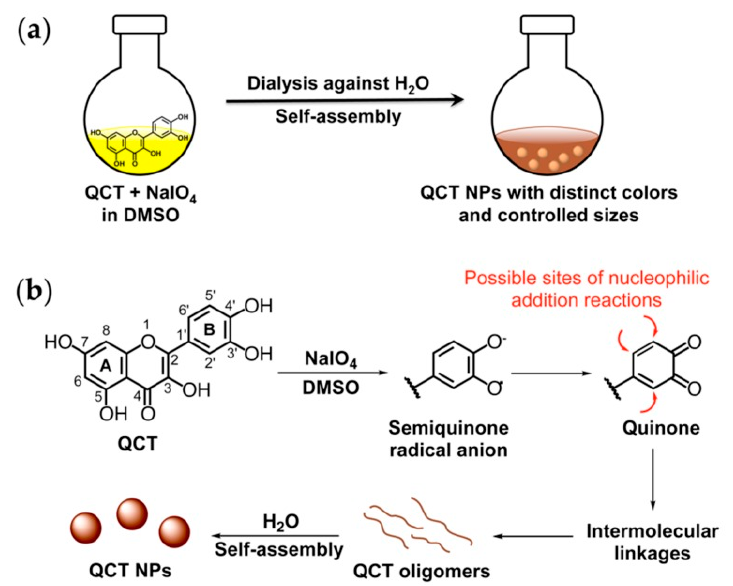
Figure 6. Synthesis process for template quercetin (QCT) nanoparticles [80] ( a ) Schematic of synthesis and ( b ) Potential chemical pathways of synthesis.